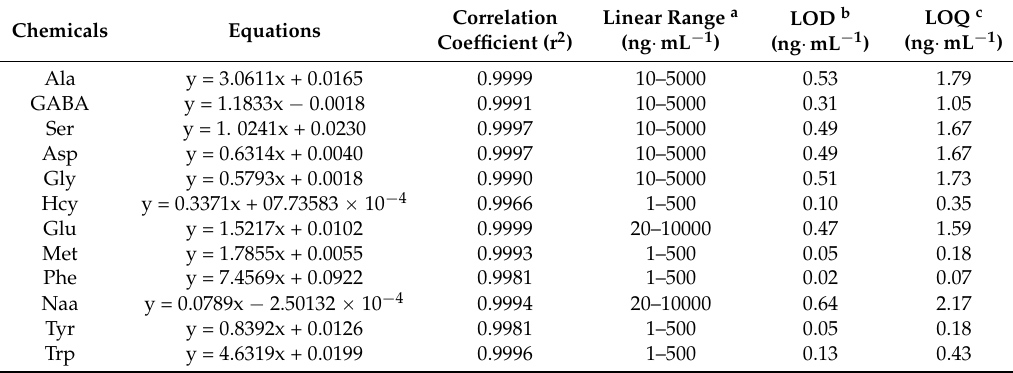
Table 2. Quantitative parameters for analysis of AAs in brain tissue.